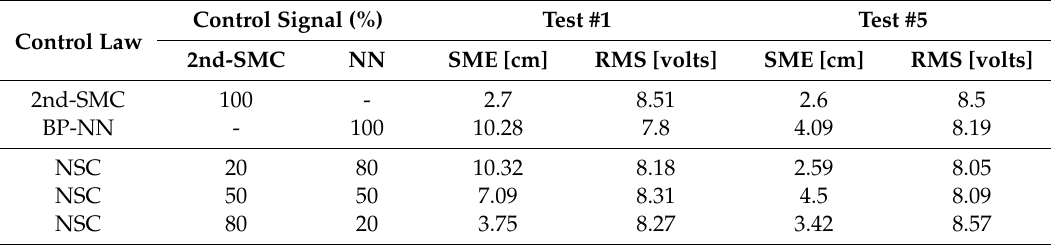
Table 2. Square mean error (SME) and e ff ective value (RMS) comparison for a set-point of z d = 0.3